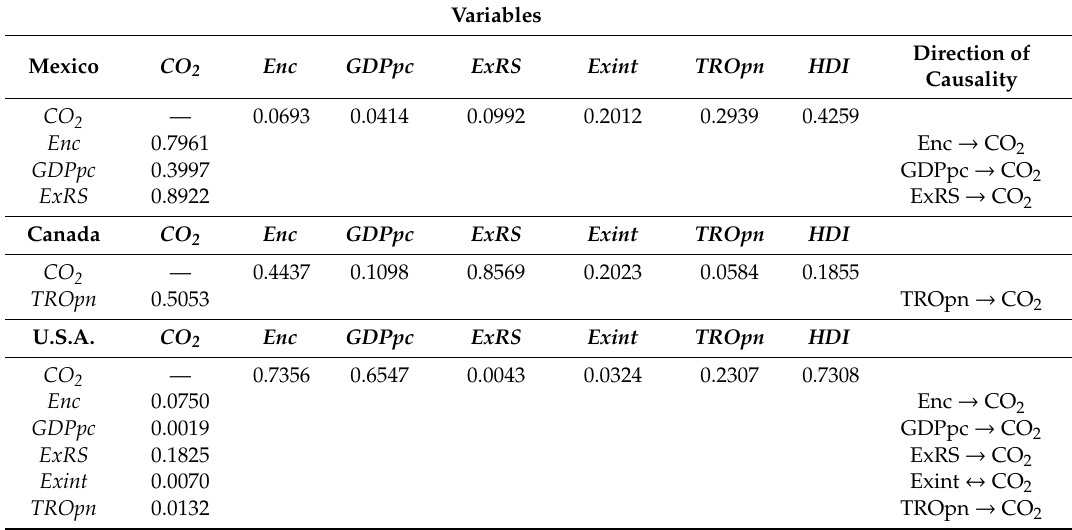
Table 3. Granger causality